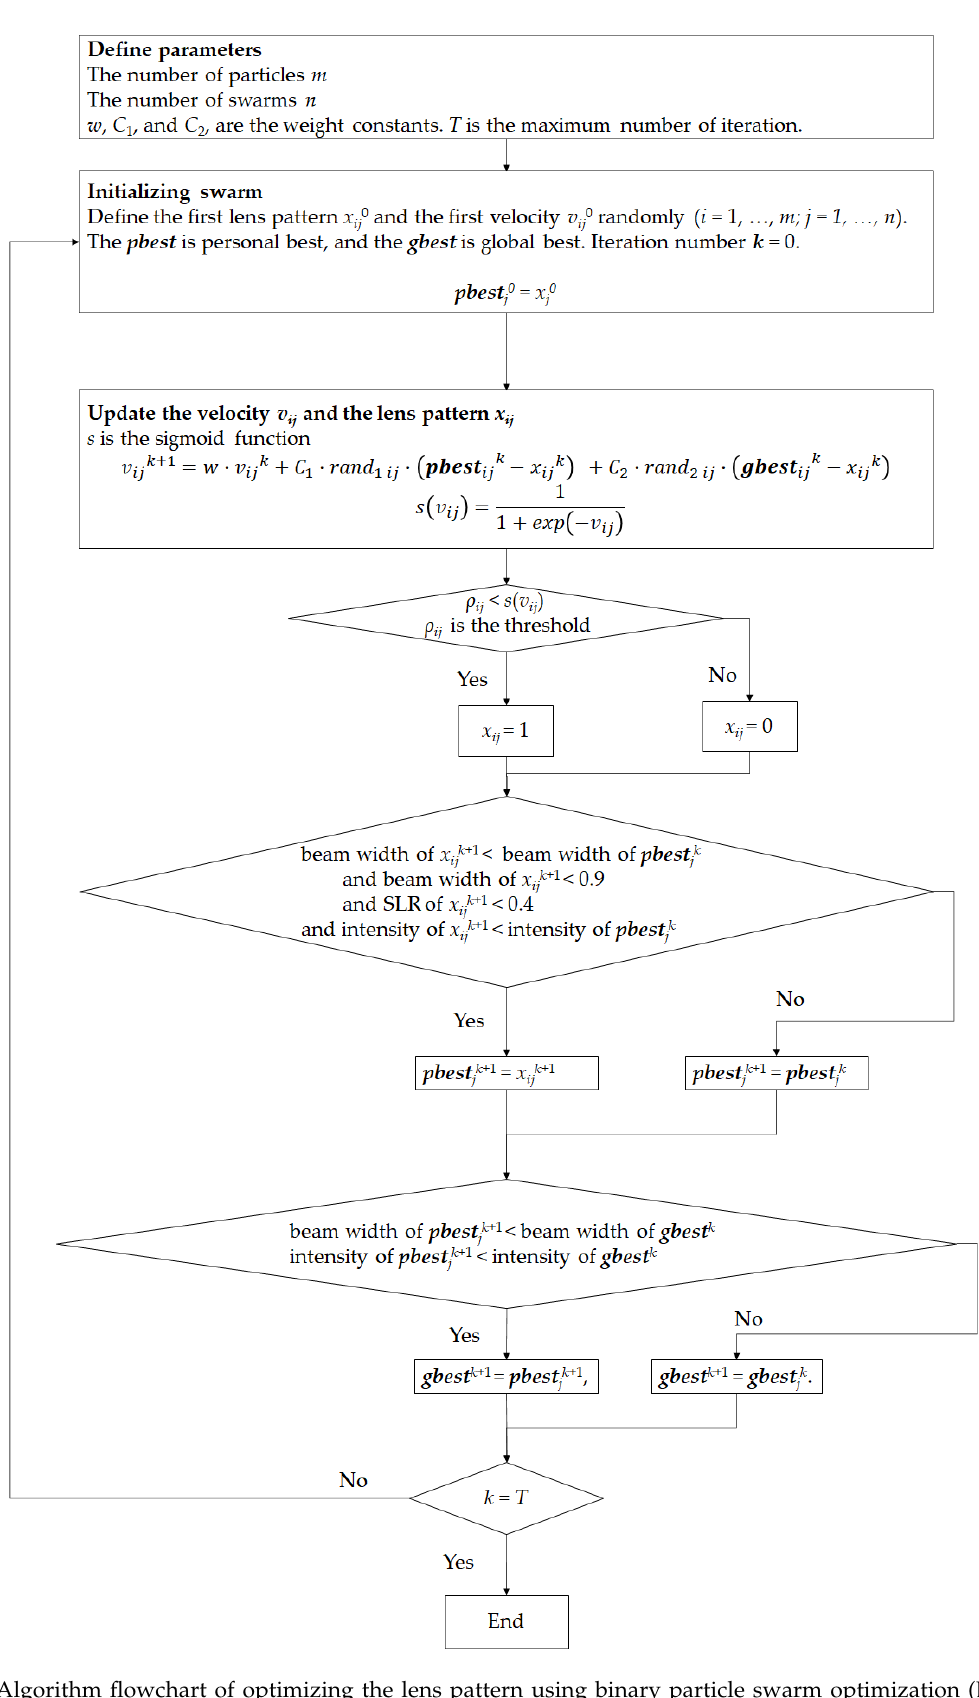
Figure 3. Algorithm flowchart of optimizing the lens pattern using binary particle swarm optimization (BPSO). The parameters are defined as m = 200, n = 100, w = 0.5, C 1 = C 2 = 1, and T = 1000.